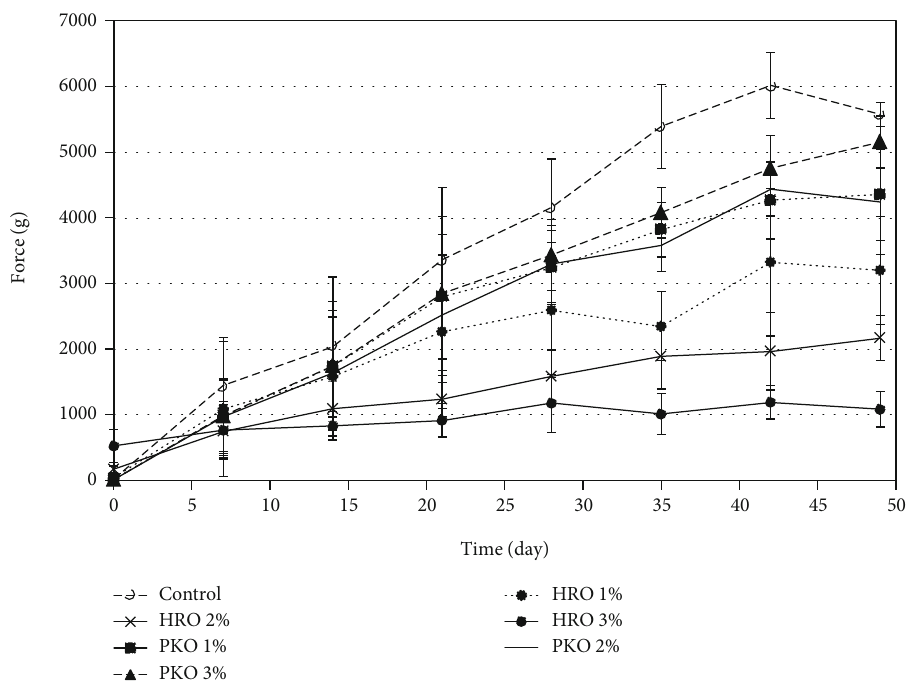
Figure 3: The e ffi cacy of HRO and PKO on the hardness of the seed butter ( 1000 g = 9 : 81 Newtons).